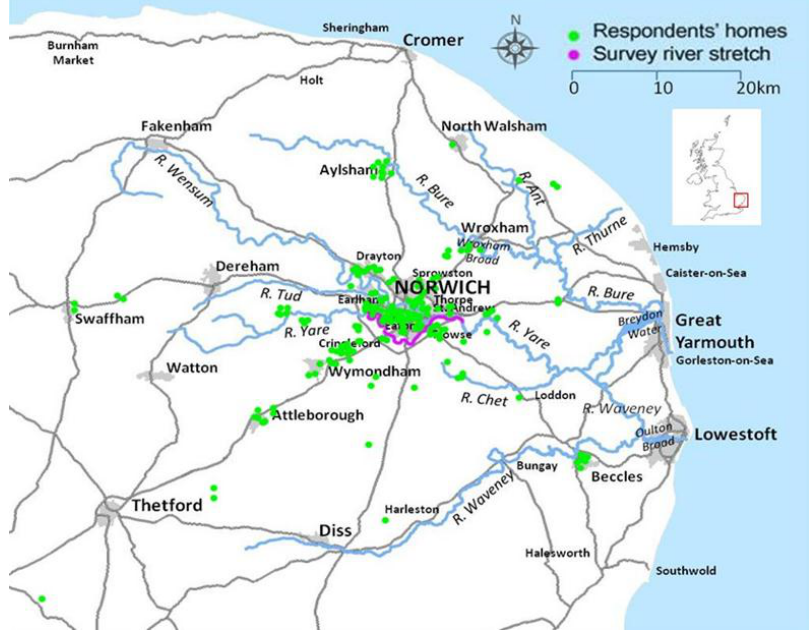
Figure 1. The survey area, survey river stretch and spatial distribution of respondents.